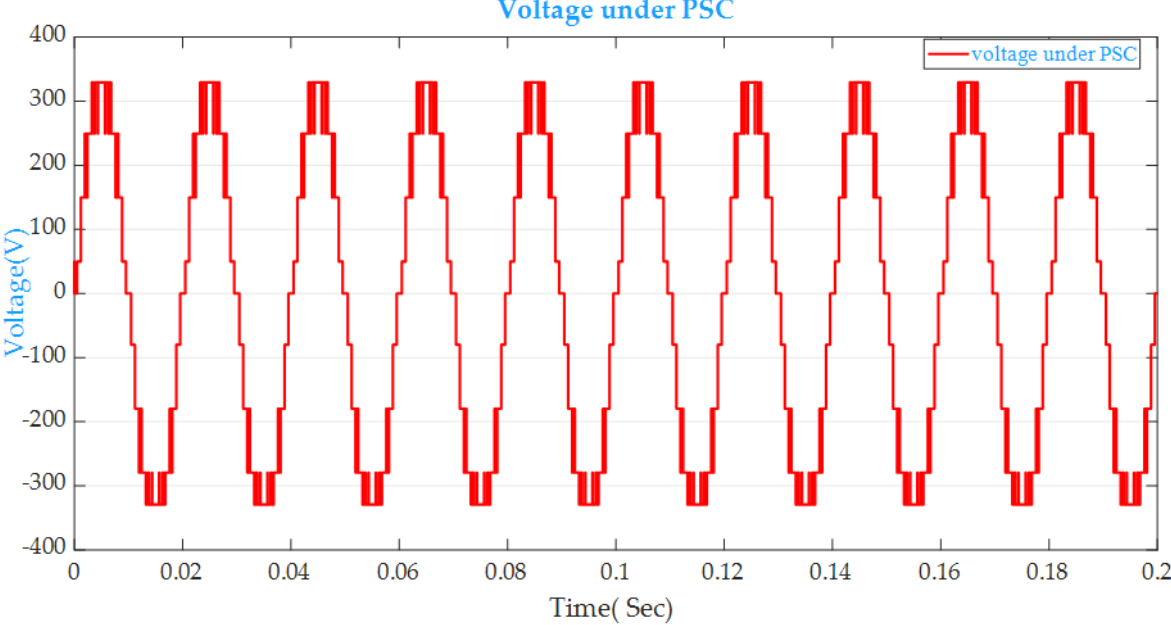
Figure 31. Output voltage of the proposed topology under PCS.